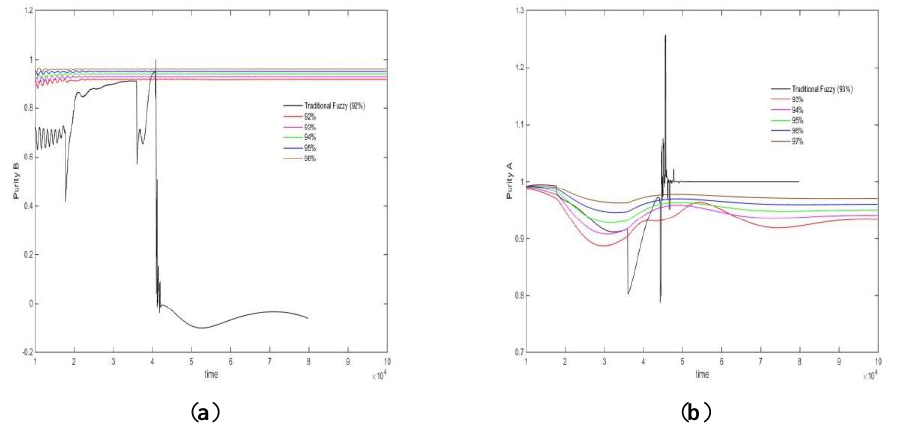
Figure 15. Under the change of the feed port concentration C f = 4.5 → 5.2. ( a ) Extraction outlet (material B); ( b ) raffinate outlet (material A).